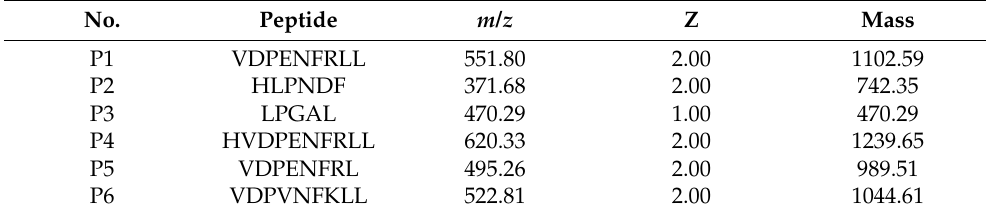
Table 3. Peptide Ranker score and binding energy data from the molecular docking Figure 2. Dipeptidyl peptidase IV (DPP-IV) inhibitory activity of each fraction. Different letters in- dicate significant differences ( p < 0.05).